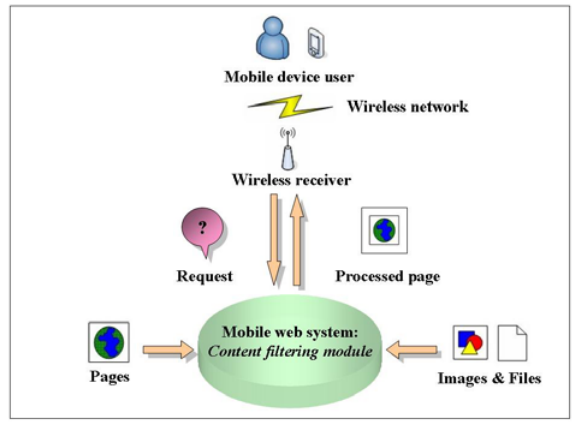
Figure 1. Mobile network